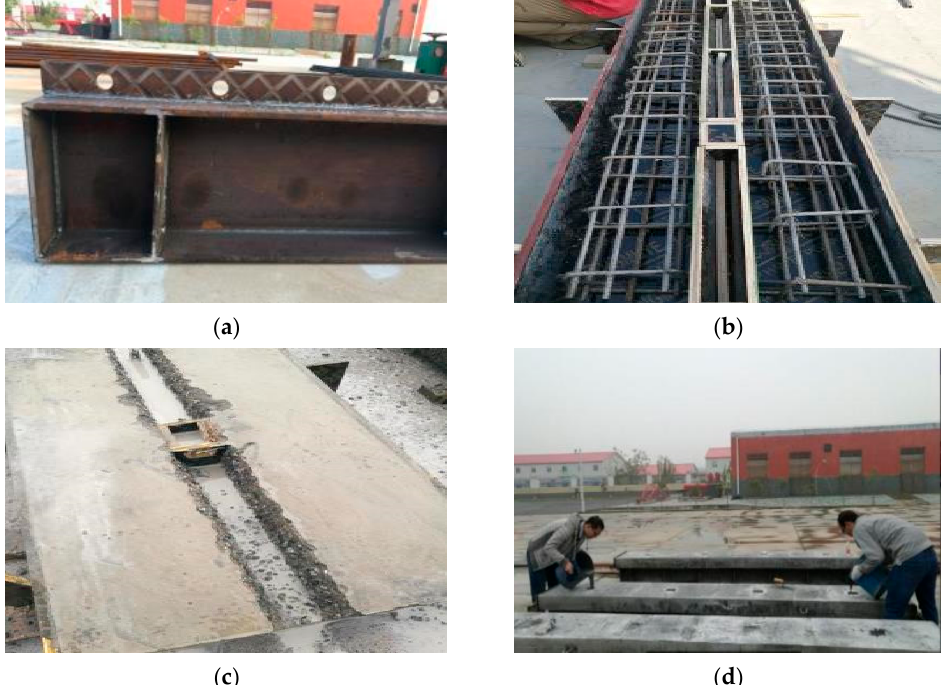
Figure 5. Fabrication of composite beam specimens: ( a ) welding of embossed steel plate; ( b ) casting of precast slab; ( c ) sand-blasting; ( d ) grouting from pockets.